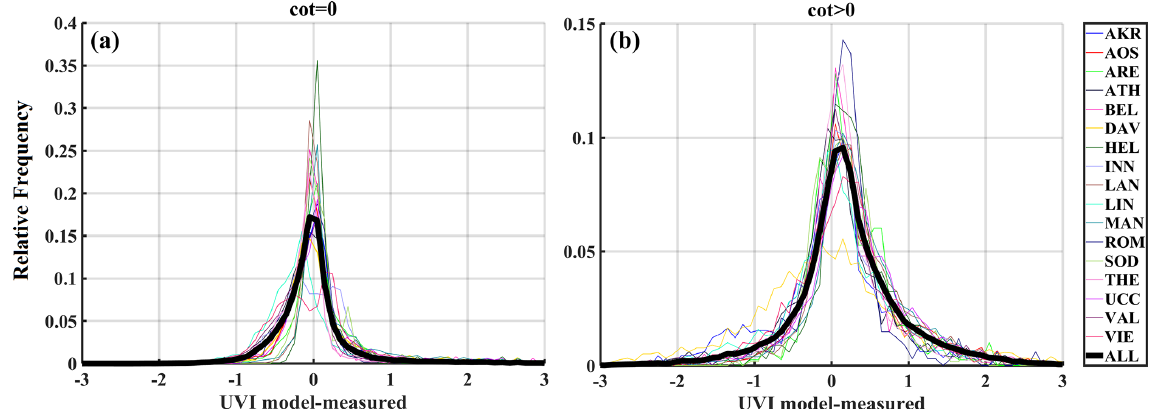
Figure 12. Relative frequency distribution of UVI residuals for all stations (colored lines) and the mean (bold black line) for cloudless (a) and cloudy (b) conditions.